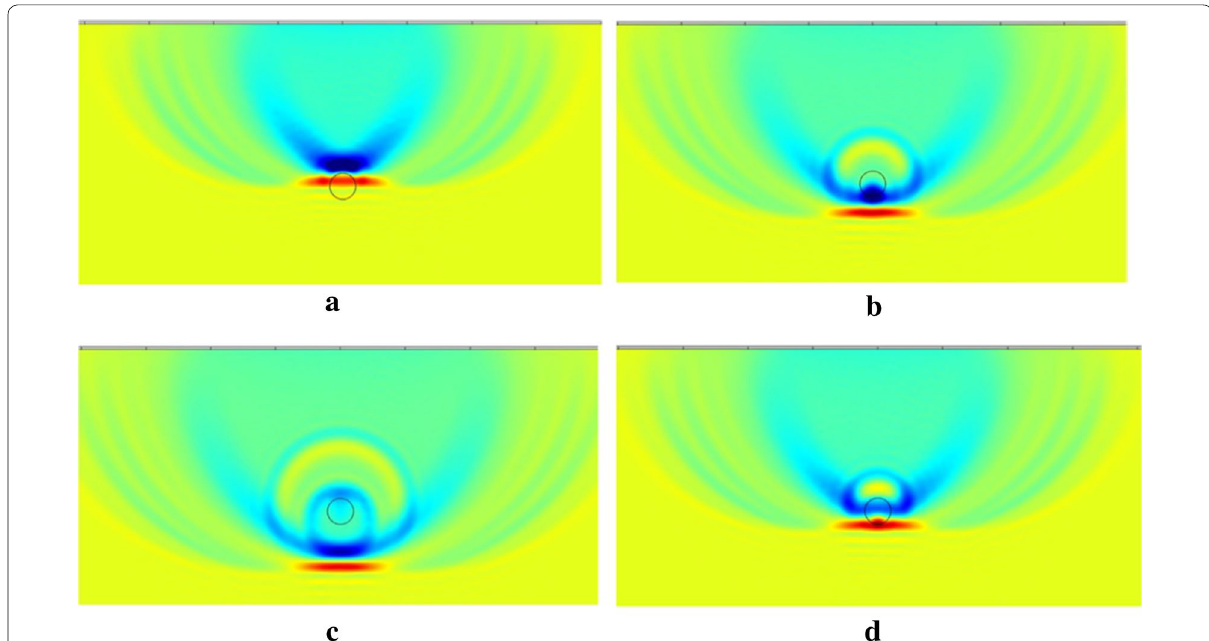
Figure 7 Snapshots of the scattered wave filed at different moments using Gaussian waves, and mode conversion occurs when acoustic waves are scattered by a cylinder: a t = 4.4 µ s , b t = 4.9 µ s , c t = 5.3 µ s , and d t = 6.0 µ